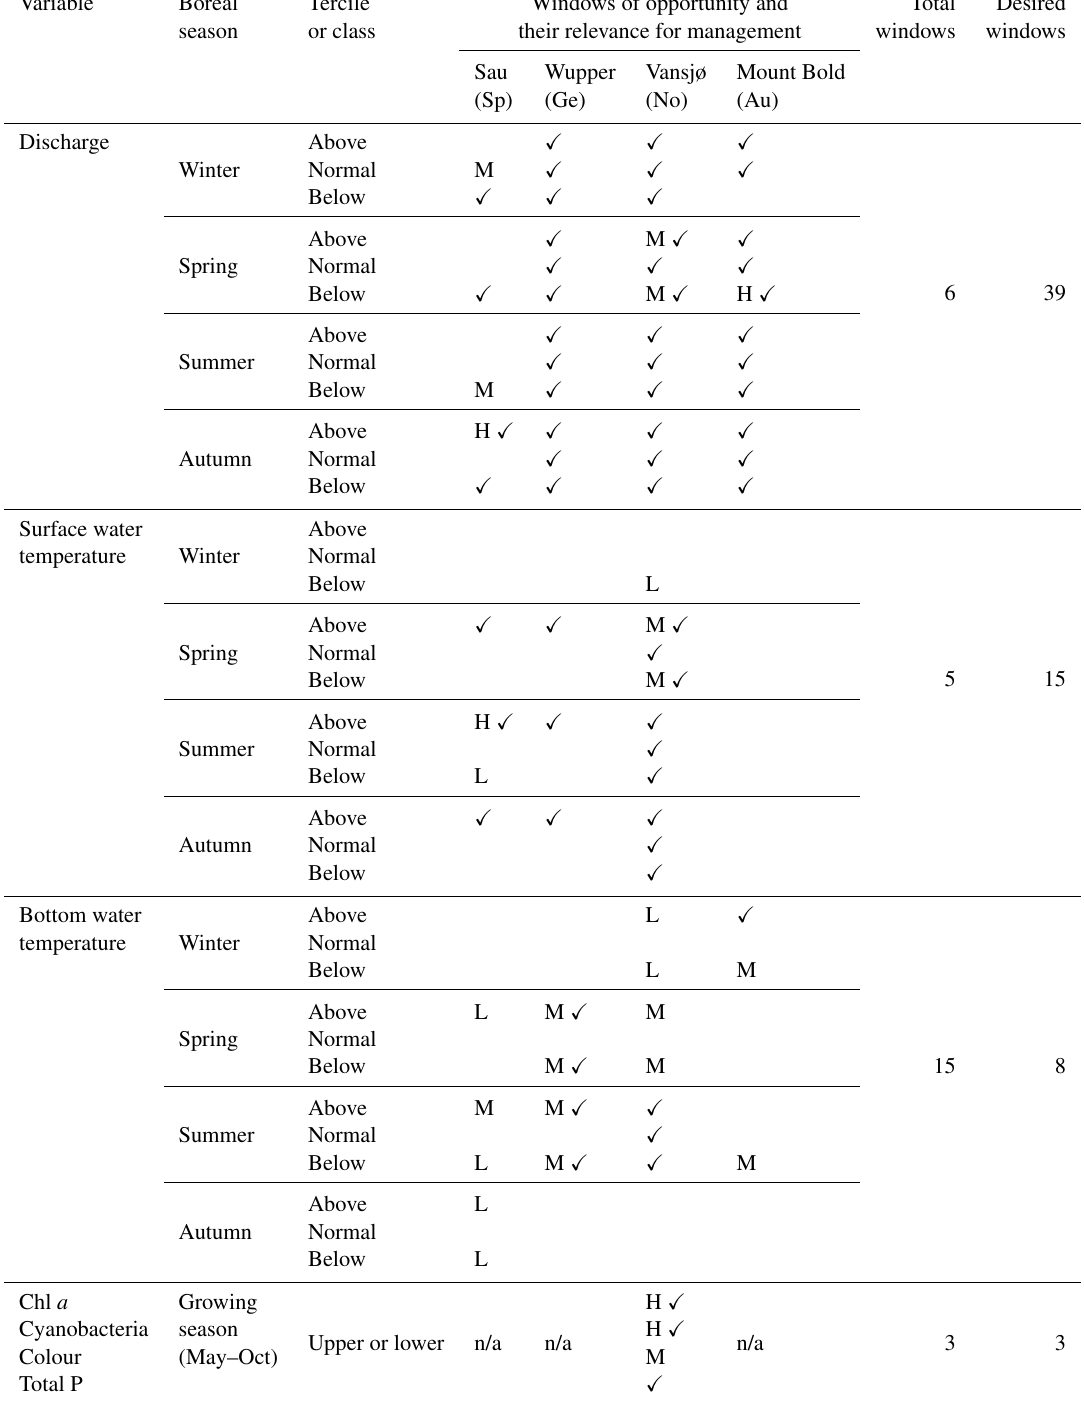
Table 5. Windows of opportunity in surface water variables and end-user assessment of their relevance for management. Note: L – low/none; M – medium; H – high. Ticks show the windows for which managers particularly wanted skilful forecasts. Where letters and ticks coincide, the window was both skilfully forecast and particularly useful. Irish case study responses are given in the